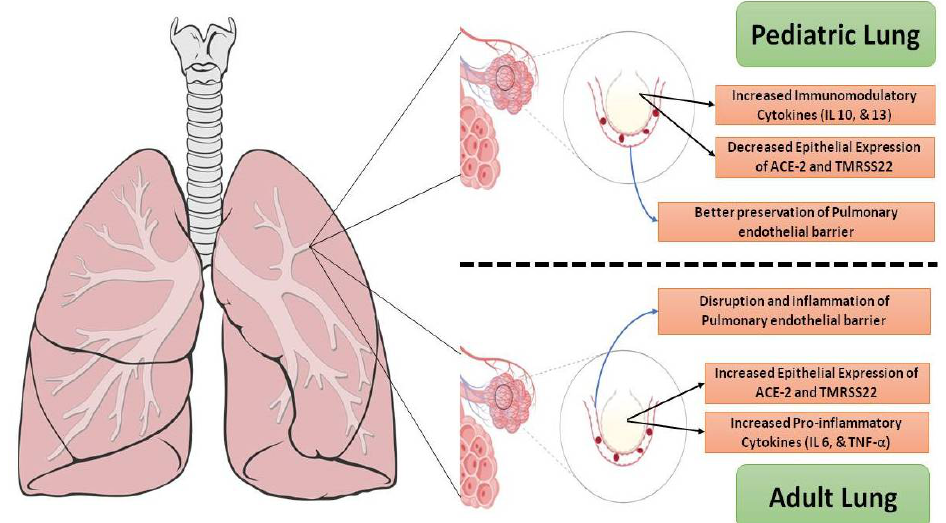
Figure 2. Mechanisms influencing the vulnerability of adults and children to SARS-CoV-2 infection. Increased expression of mediators essential for viral entry into airway epithelial cells (ACE-2 and TMPRSS2) in adults combined with the proinflammatory milieu may predispose the adult lung to serious pulmonary injury and progression to acute respiratory distress syndrome (ARDS). The pe- diatric lung has greater expression of immunomodulatory cytokines and possibly a decreased ex- pression of viral entry